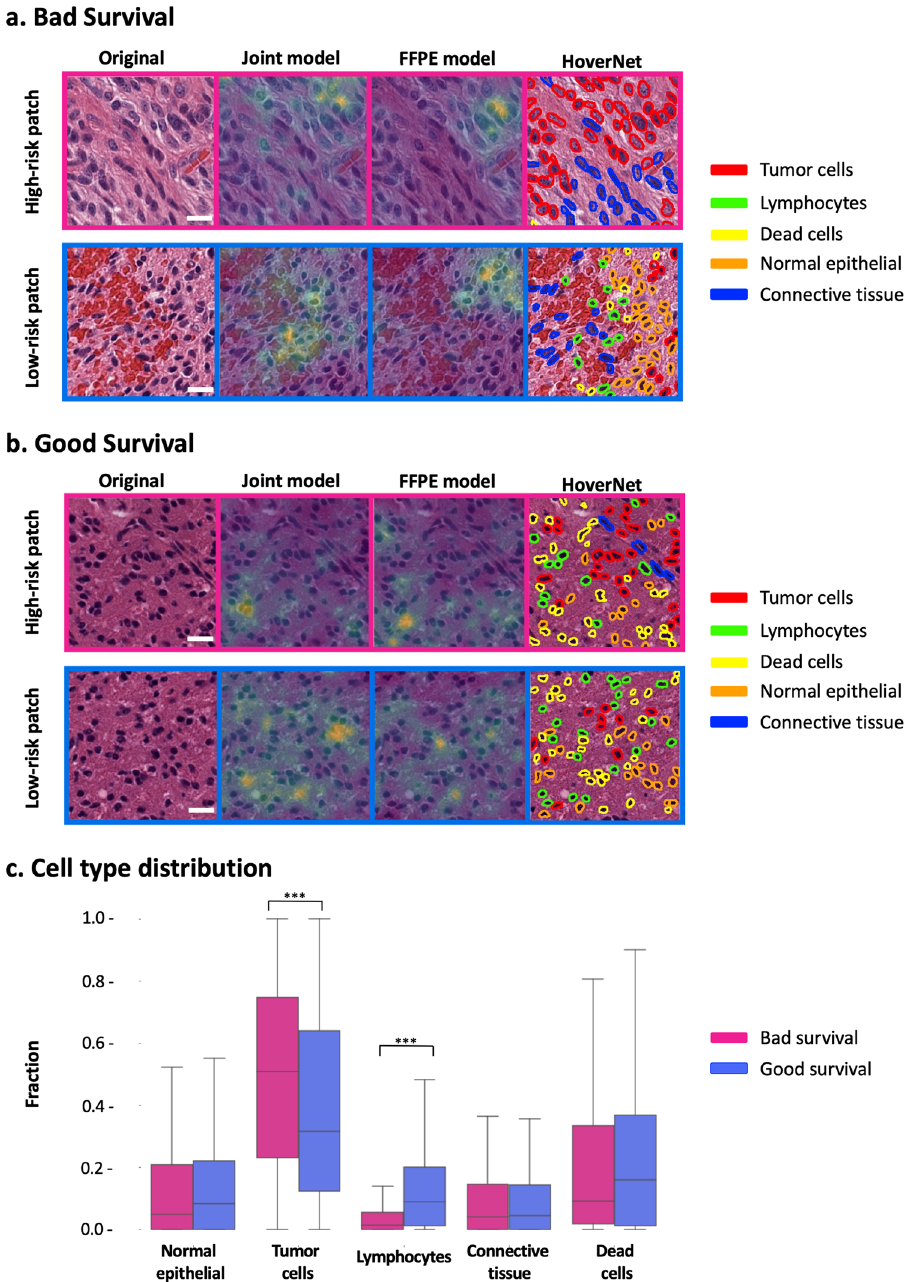
Fig. 7 Interpretability analysis of histopathology model with respect to survival predictions and cell type distributions. a Examples of high-risk and low- risk patches for a bad survival sample. b Examples of high-risk and low-risk patches for a good survival sample. Left panel = original 224 × 224 patch, scale bars (white insets), 20 µ m; middle panels = overlayed saliency map for joint fusion and histopathology (FFPE only) models, Right panel = cell segmentation predicted by HoverNet 50 . c Quantitative analysis of cell type composition in extracted 224 × 224 patches of bad survival and good survival samples of the adult glioma test set. (*** P value < 2.2e-16, two sample t test, high-risk N = 78, low-risk N =